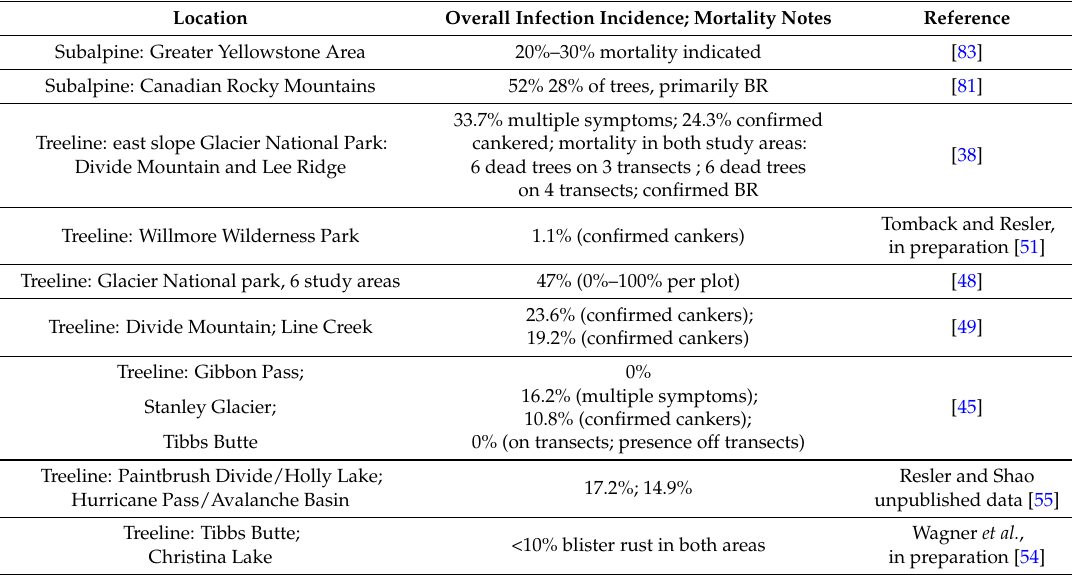
Table 5. Incidence of infection by white pine blister rust (BR) in subalpine forests in the Central and Northern Rocky Mountains, and incidence of blister rust at treeline across the Rocky